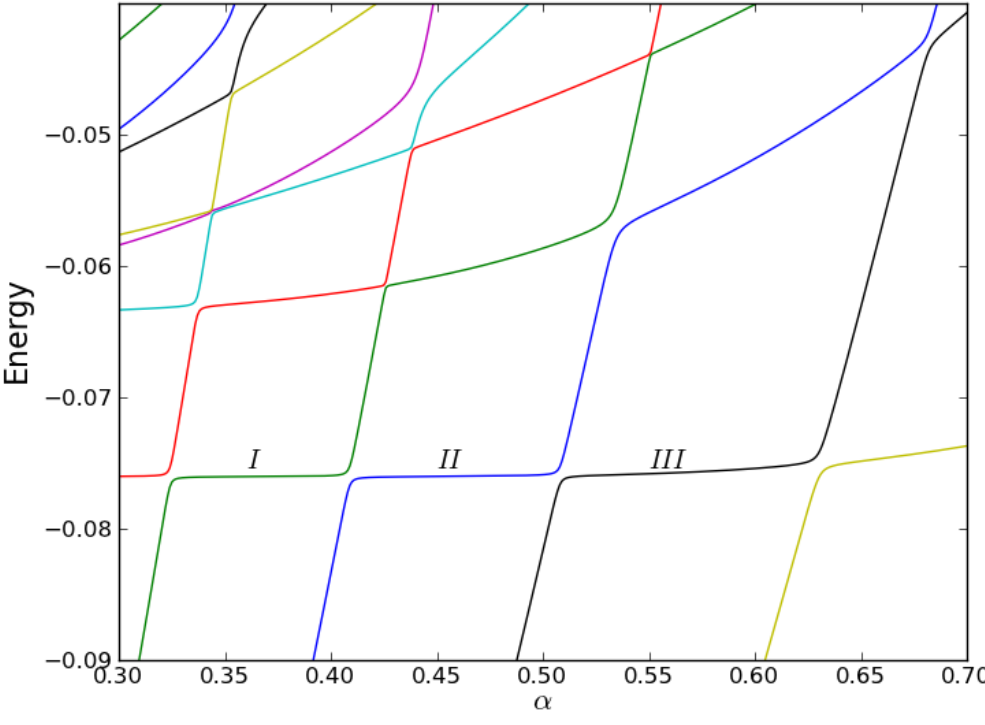
Figure 1. Stabilization plot for the doubly excited 2 s 2 1 S e state in Ps −